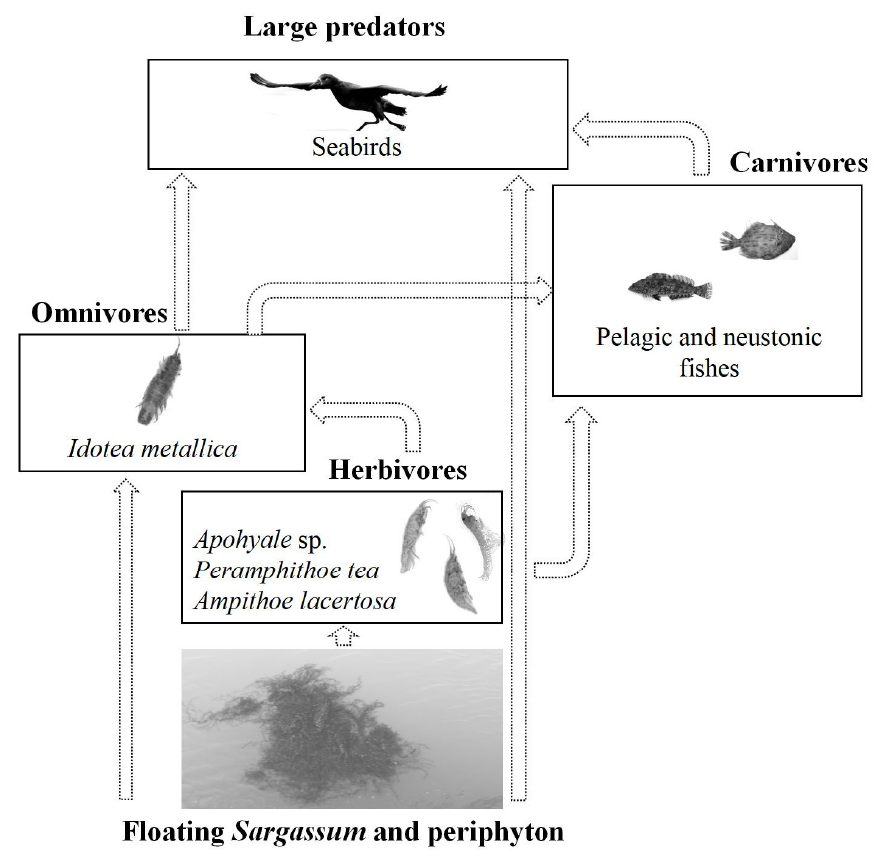
Figure 8. Flowchart of the floating Sargassum ecosystem.